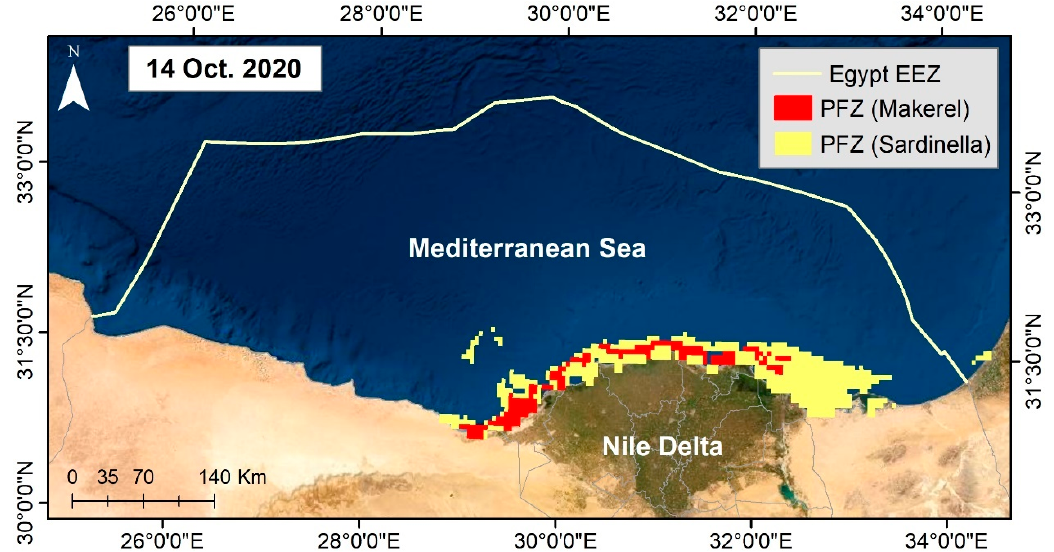
Figure 15. PFZ for Sardinella aurita and Makerel Tuna on 14 October 2020.